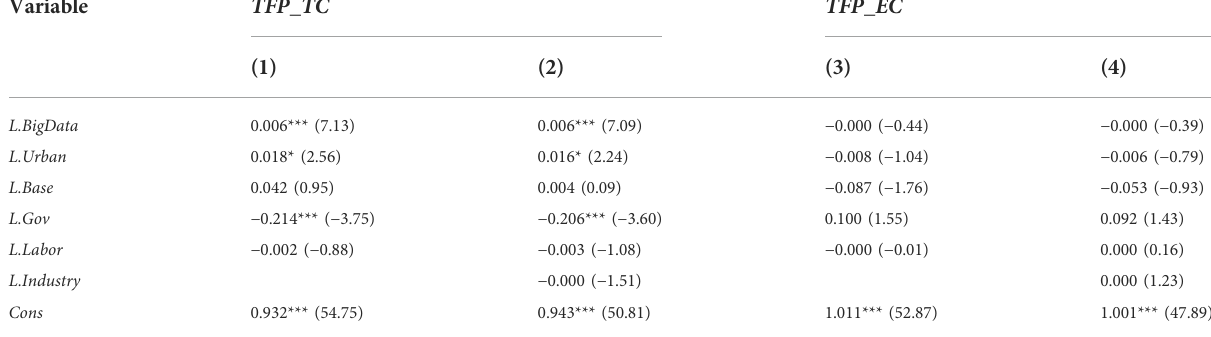
TABLE 9 Robustness test for one-lag explanatory variables.